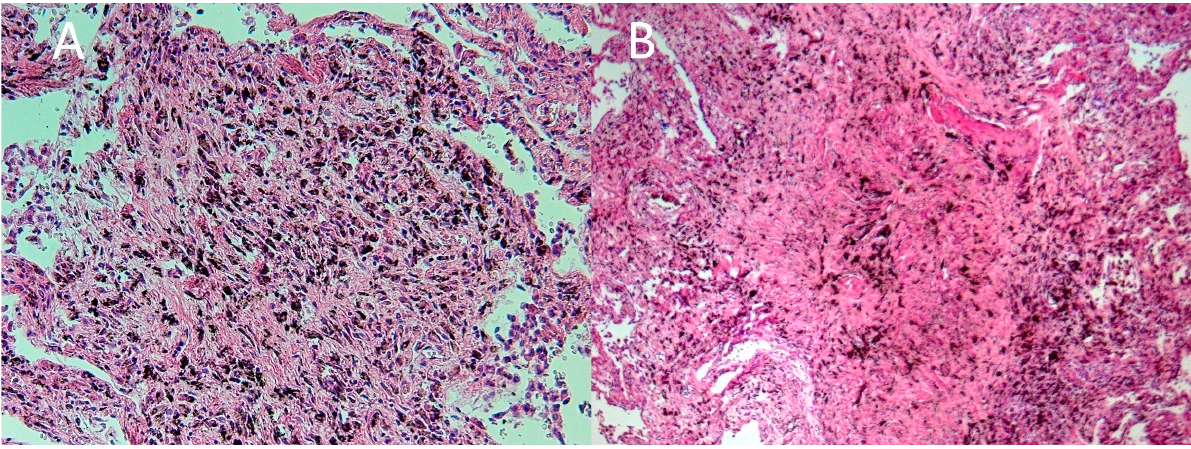
Figure 5. ( A ) Granuloma in the lung tissue with intense inflammation. Magnification × 100. Hematoxylin and eosin stain (H&E), ( B ) silica nodule with an amorphous substance and an inflammatory reaction surrounding it. Magnification × 100, H&E.